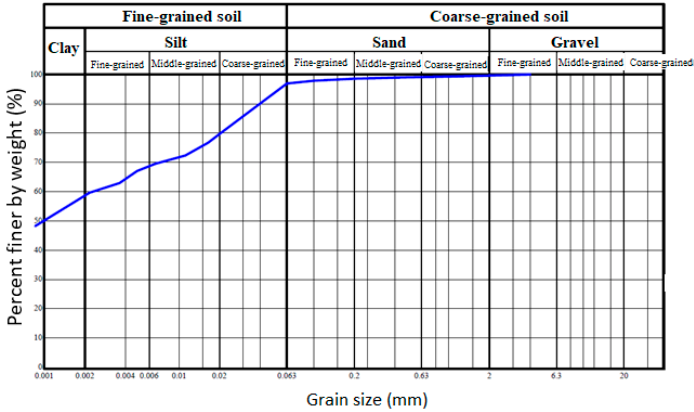
Figure 3. The granulation curve of soil from Central Europe (Brno, CZ), XRD analysis of clay soil ‘Cl’.